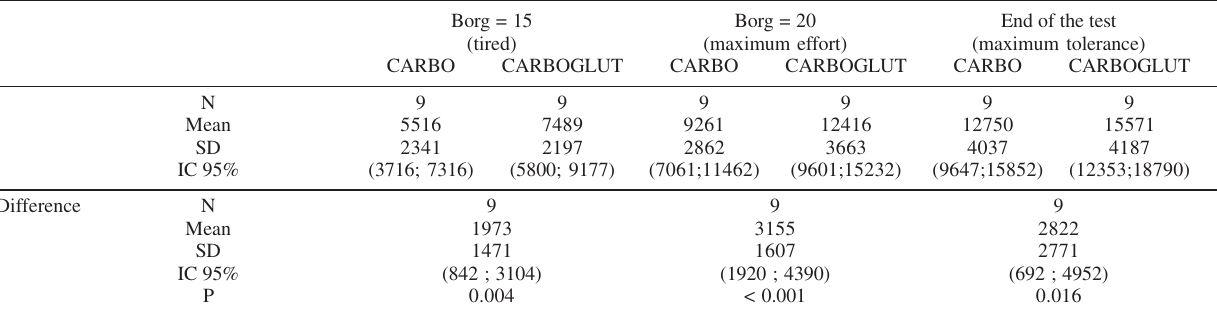
Table 3 – Comparison of the distance covered in relation to the perception of fatigue verified by the subjective Borg scale at three moments of exercise in soccer players supplemented with carbohydrate alone (CARBO) and the mixture of carbohydrate and peptide glutamine (CARBOGLUT).